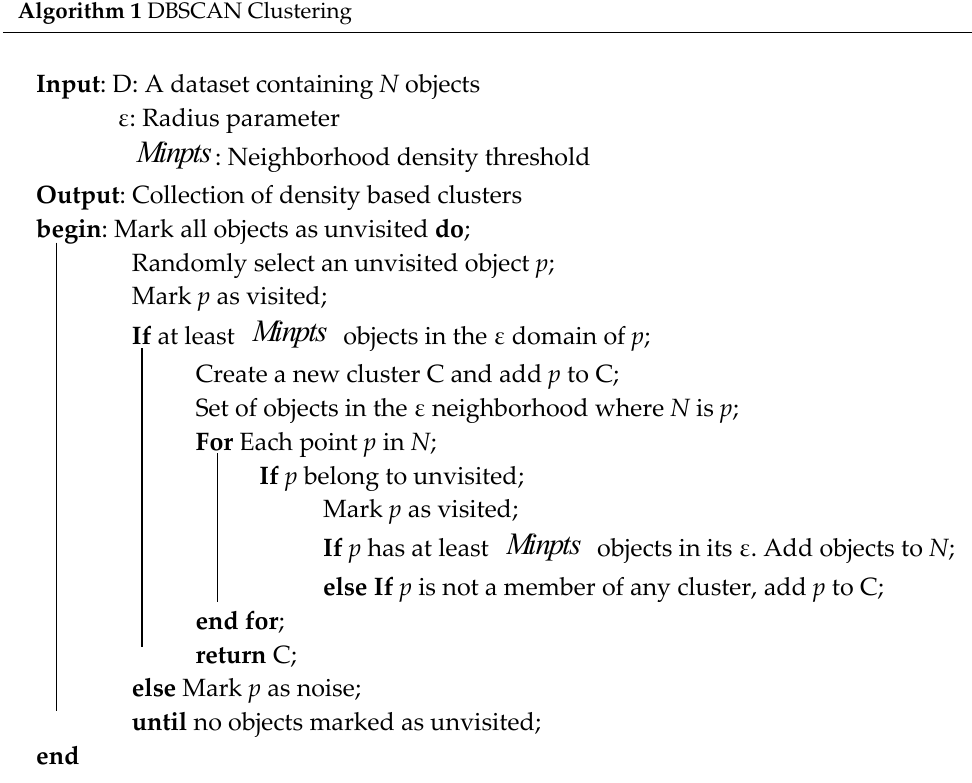
Algorithm 1 DBSCAN